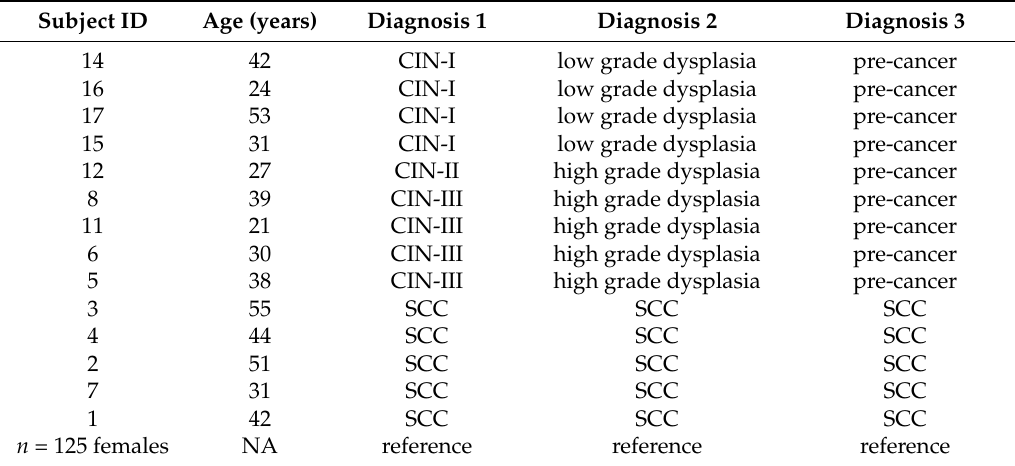
Table 1. Clinical demographics with diagnosis, age for cases and reference